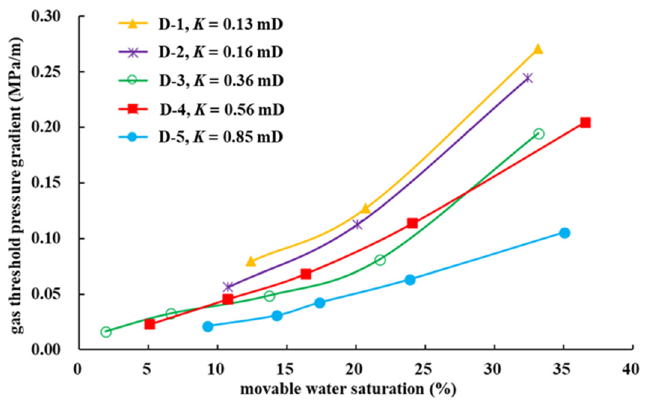
Figure 9. The relationship between TPG and movable water saturation.